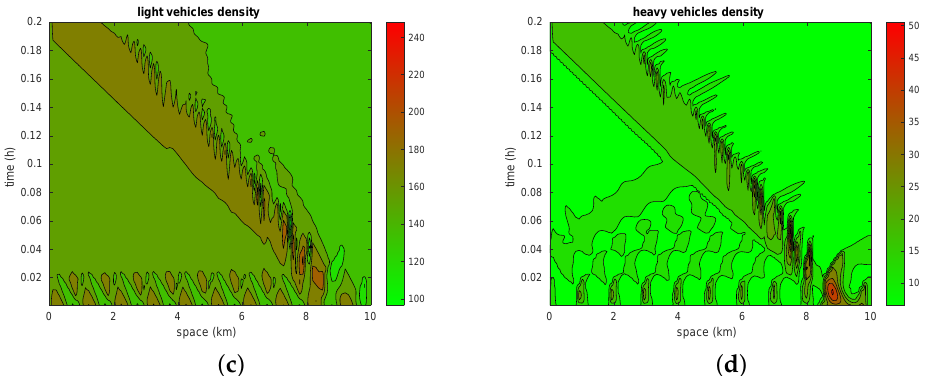
Figure 14. Test 3A: ( a ) Density and ( b ) velocity of light and heavy vehicles as a function of space at t = ∆ t (i.e., just after the initial time). ( c ) Density of light and ( d ) heavy vehicles in space–time. The evolution of the initial perturbation in the truck density starting at 9 km is perfectly visible, which creates, in turn, a perturbation in the car density.